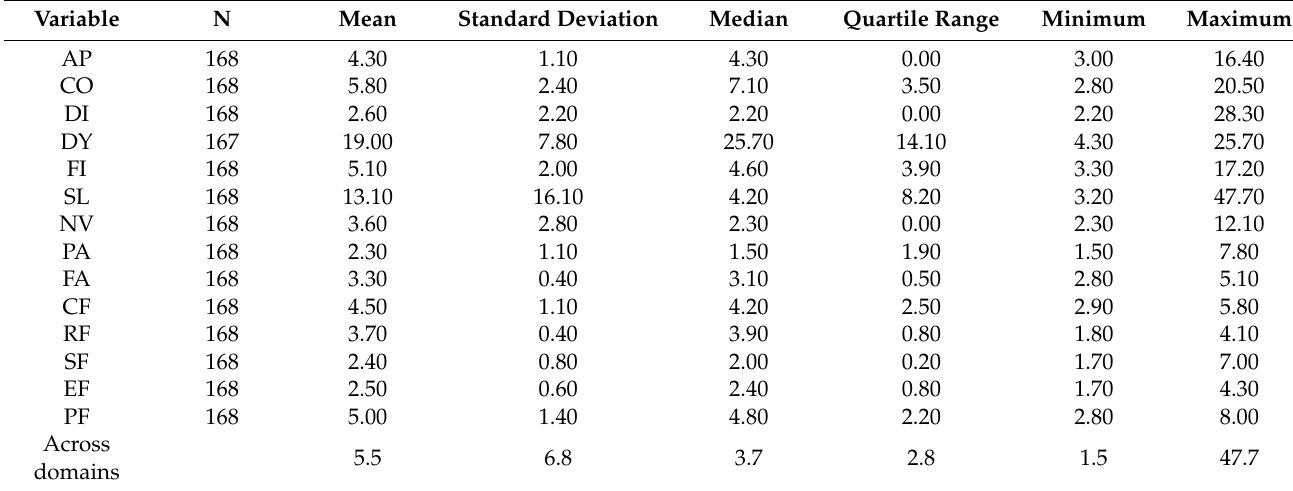
correlation for dyspnoea in the Brazilian sample is likely because most participants (87%) answered “not at all” to the QLQ-C30 item, but when asked about more demanding tasks (like walking up one flight of stairs), some (approximately 20%) responded “a little” or “quite a bit” dyspnoea. Hence, the relatively low correlation is mainly a result of a low sensitivity of the original item for individuals with little dyspnoea. Otherwise, the correlations between EORTC CAT Core and QLQ-C30 scores in the Brazilian sample were high and comparable to those found in the European cohort; for the comparisons between the two cohorts at T0, the median difference between correlation coefficients across all domains is <0.01. Table 4. Brazilian data. Relative precision of the EORTC CAT Core compared to QLQ-C30 scores (informa- tion(CAT)/information(C30)).